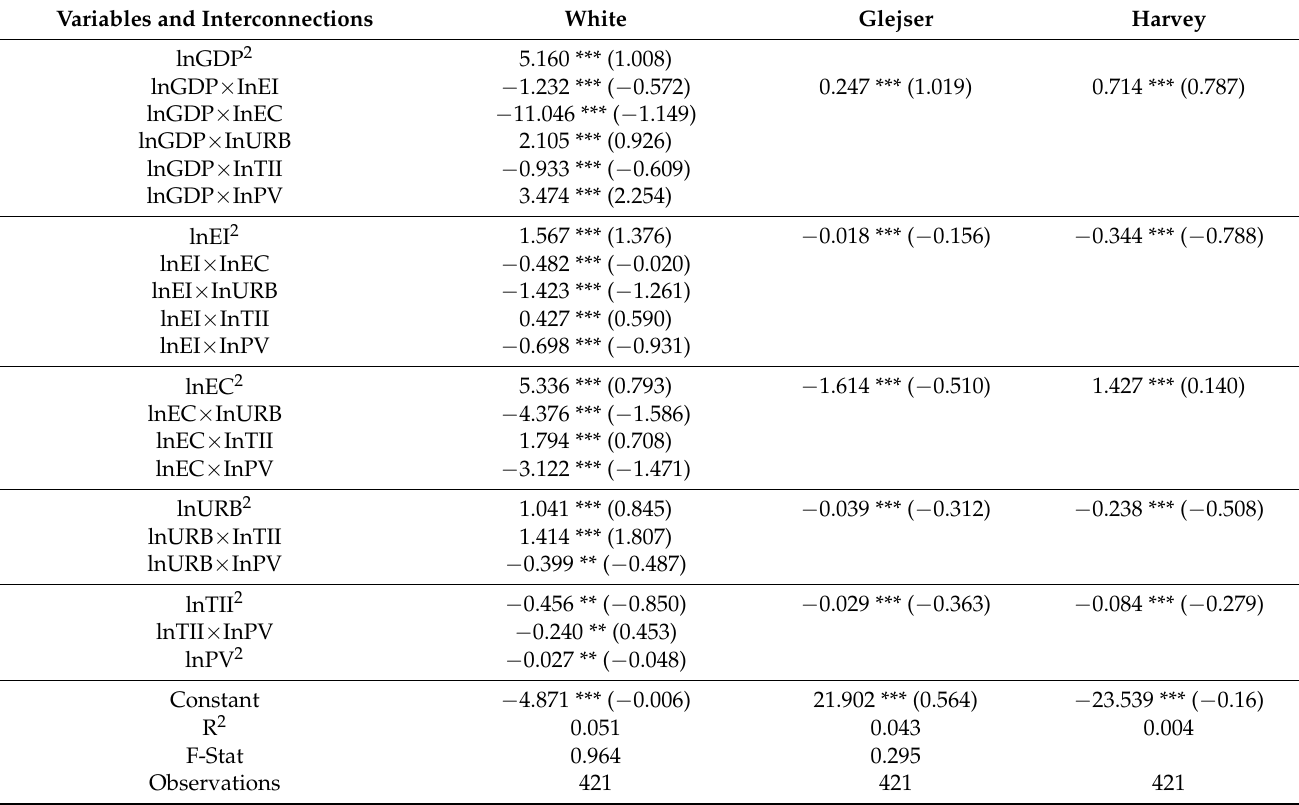
Table 8. Diagnostics results: heteroskedasticity of the transport sector CO 2 - eq emissions. Variables and Interconnections